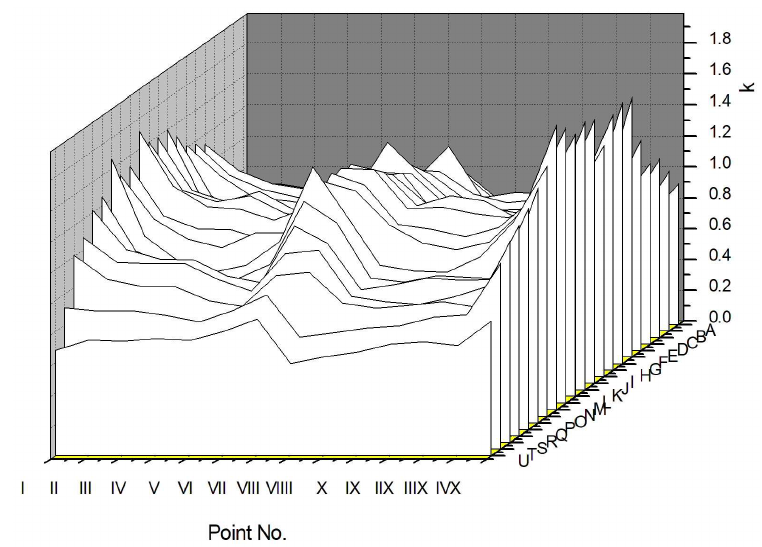
Figure 8. Profile of k in the dark field for black matrix (BM) thin-film.